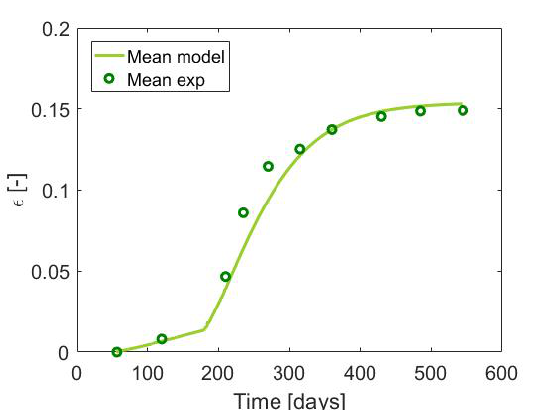
Figure 3. Mean strain evolution in the free expansion test: Comparison between experimental ASR-only data by Gautam, et al. [28] and model